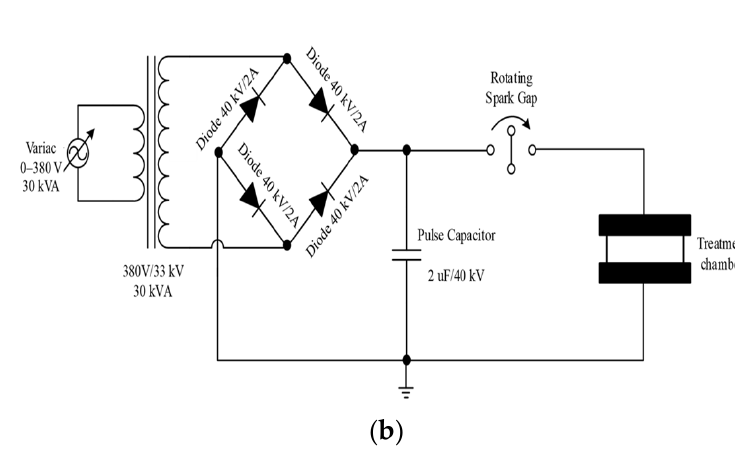
Figure 1. Thai PEF machine prototype ( a ) and PEF diagram ( b ) used in this study.